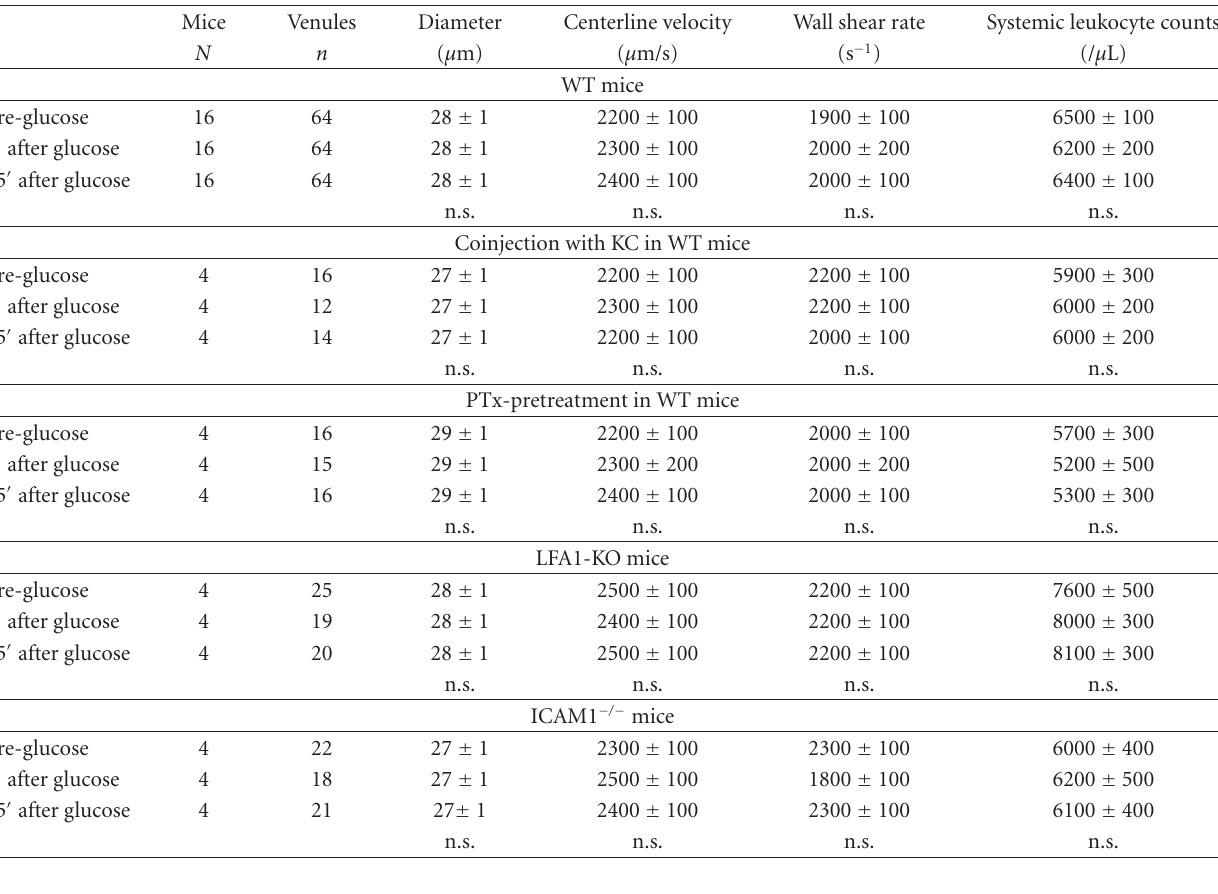
Table 3: Hemodynamic and microvascular parameters of cremaster muscle venules in ICAM1-KO, LFA1-KO, and PTx-pretreated or KC- coinjected WT mice before and after injection 0,5 g/kg glucose in the trauma model. Vessel diameter, centerline velocity, and wall shear rate are displayed before and after the intravenous administration of glucose. Experiments are presented as mean ± SEM; n.s.: not significant stating no di ff erences of hemodynamic parameters among the di ff erent groups and during the time course after glucose/saline injection.